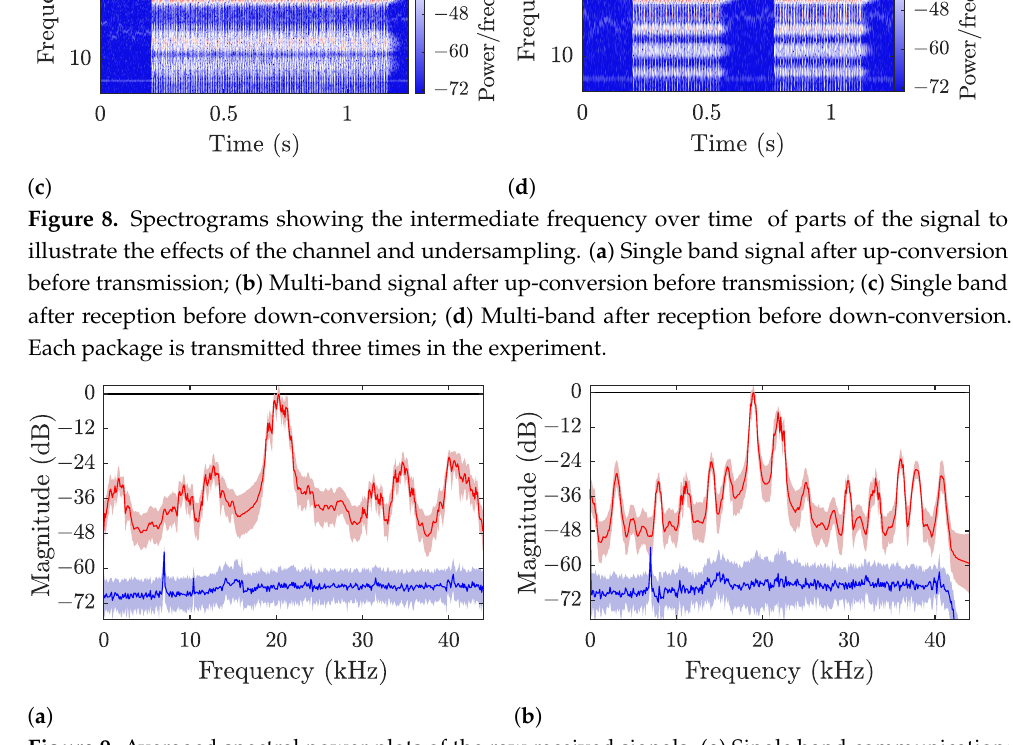
Figure 9. Averaged spectral power plots of the raw received signals. ( a ) Single band communication; ( b ) Dual-band communication. The colored area marks the ± 1 σ region of each frequency